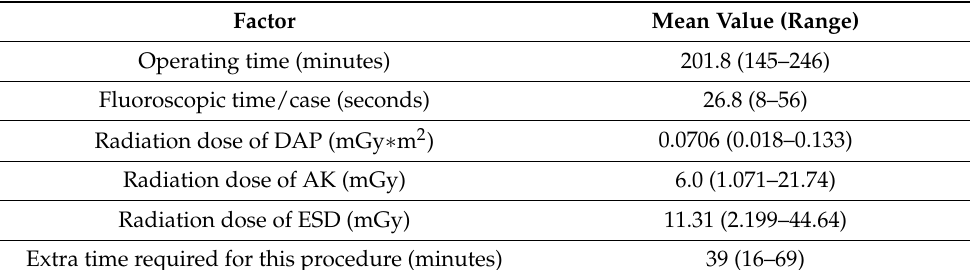
Table 2. Surgery and radiation data for 24 patients who underwent MIS TLIF.